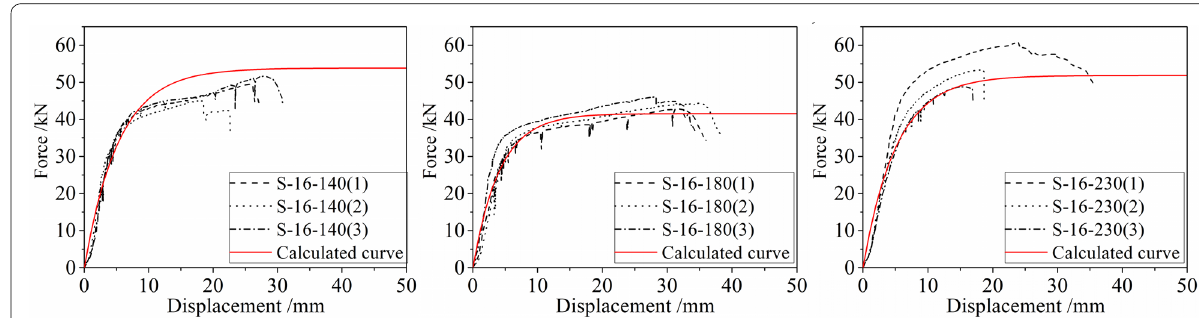
Fig. 13 Comparison of calculated curves and experimental curves